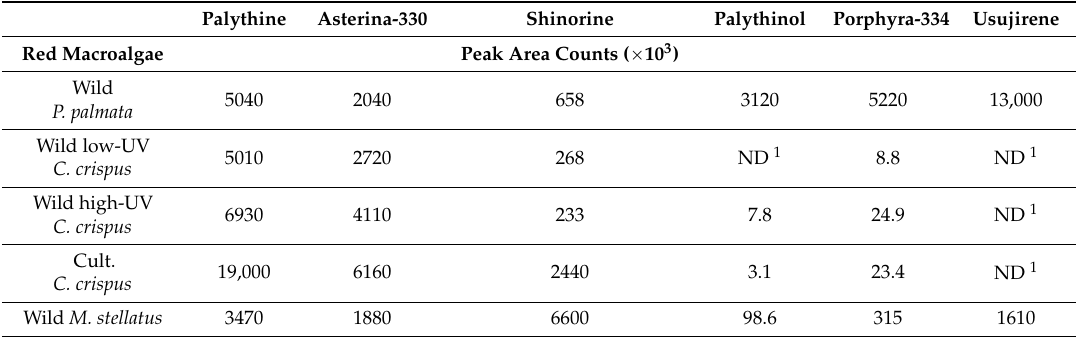
Table 1. Mycosporine-like amino acid composition of wild-harvested and cultivated red macroalgal extracts determined from LC/MS/MS multiple reaction monitoring 1 . Palythine